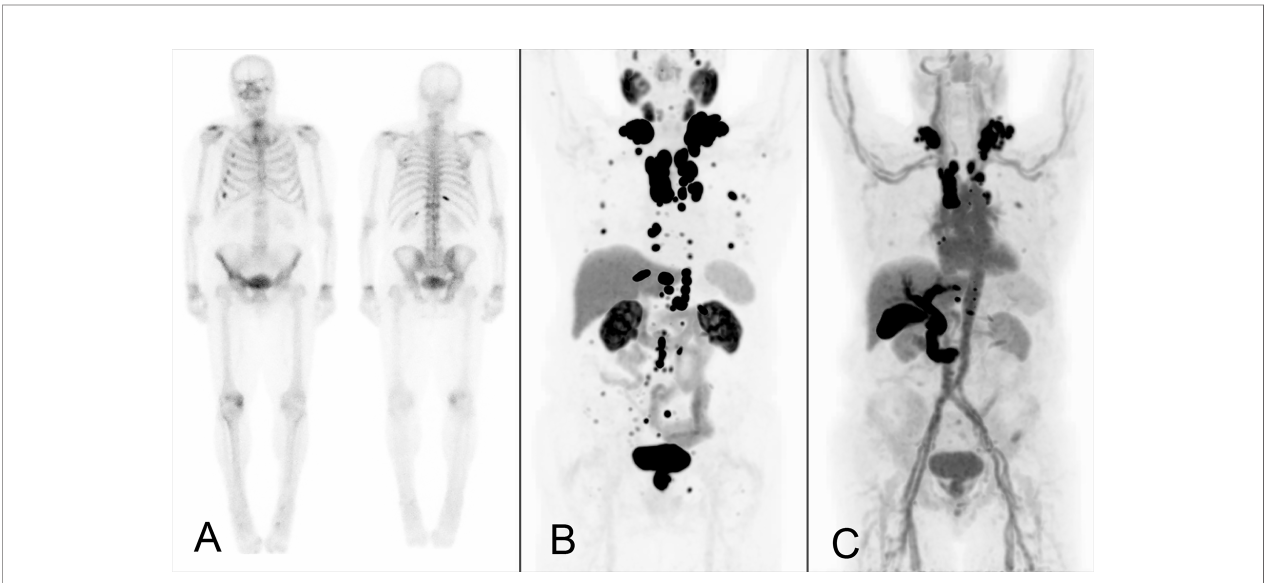
FIGURE 3 | Exampleof a malepatientwith boneand lymph nodemetastases from castration-resistant prostate cancer whounderwent bone scintigraphy (A) and 18 F- DCFPyL (B) and 18 F-FDHT PET (C) for research purposes. Bone scintigraphydemonstratedseveral rib metastases. A large number of additional (measurable) bone metastases were observed on 18 F-DCFPyl PET, with additional lymph nodemetastases detected on-par. Disconcordant AR-expression visualized on 18 F-FDHT